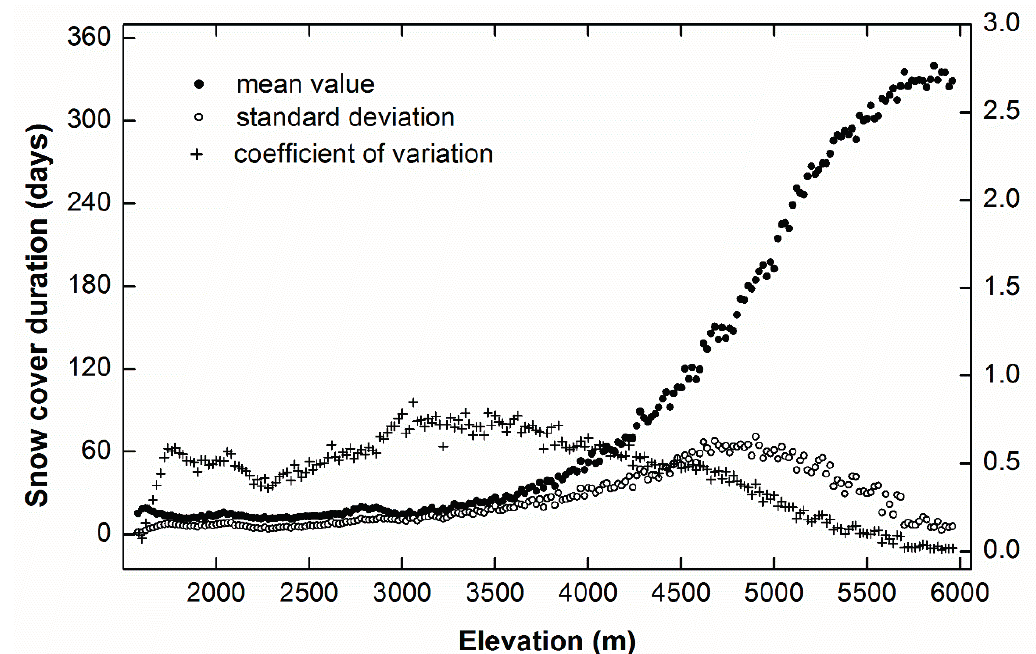
Figure 8. Variation of the mean (black dots), standard deviation (white dots), and CV (plus signs) of annual SCD with elevation.